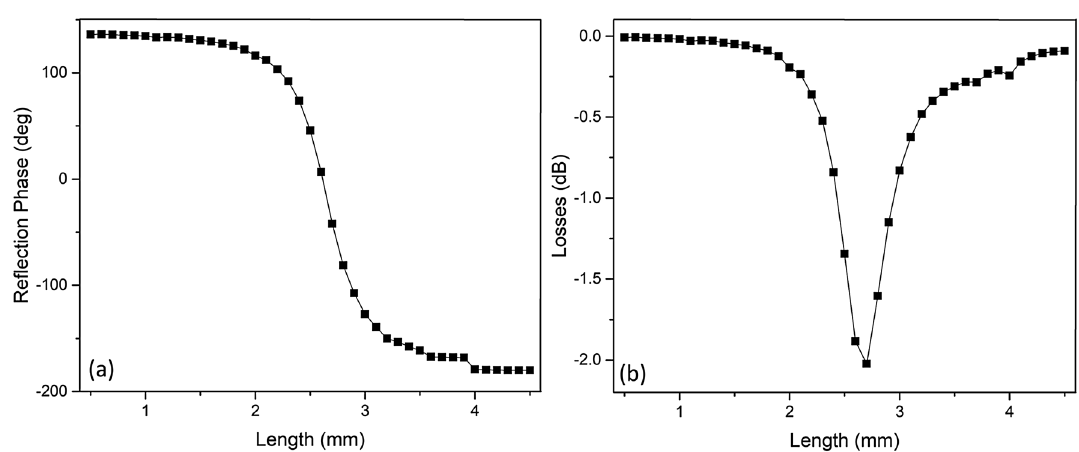
Figure 5. Reflection phase curve ( a ) and loss curve ( b ) of the simulated hybrid structure for 32